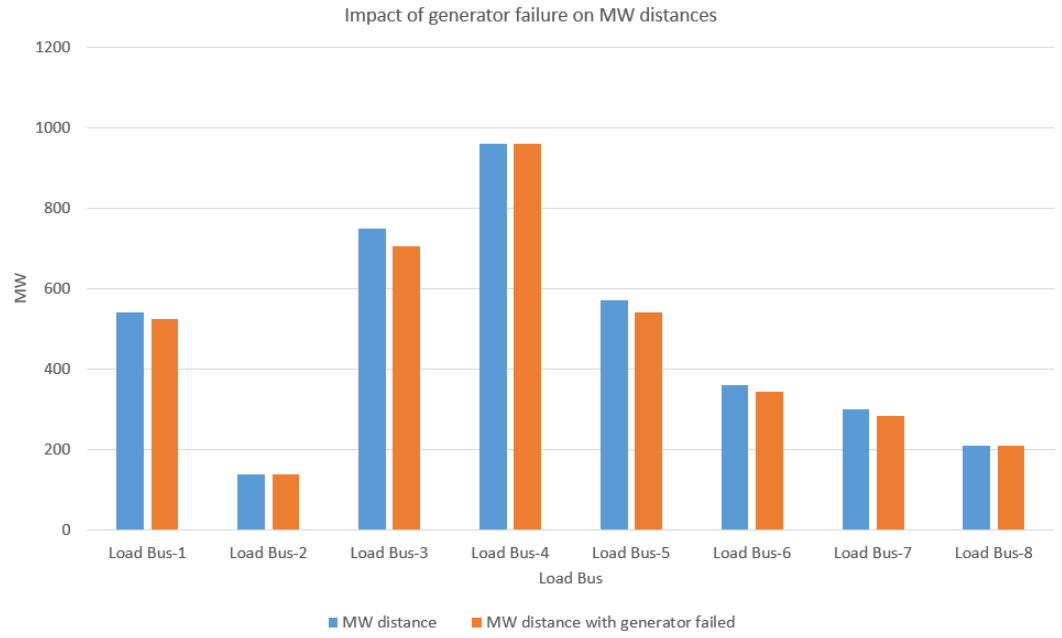
Figure 9. Impact of generator failure on MW distances.